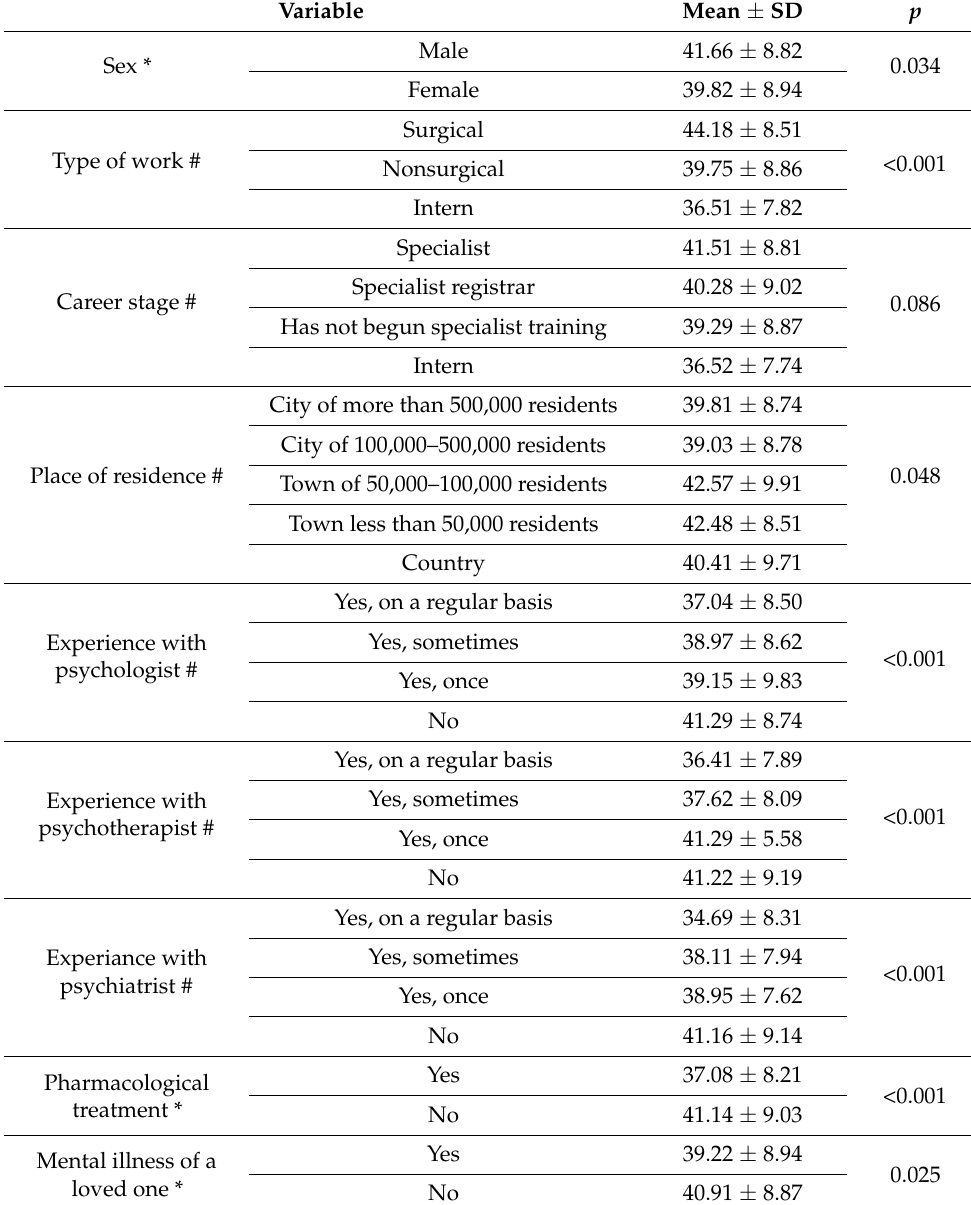
Table 4. A detailed analysis of the effect of individual factors on MICA-4